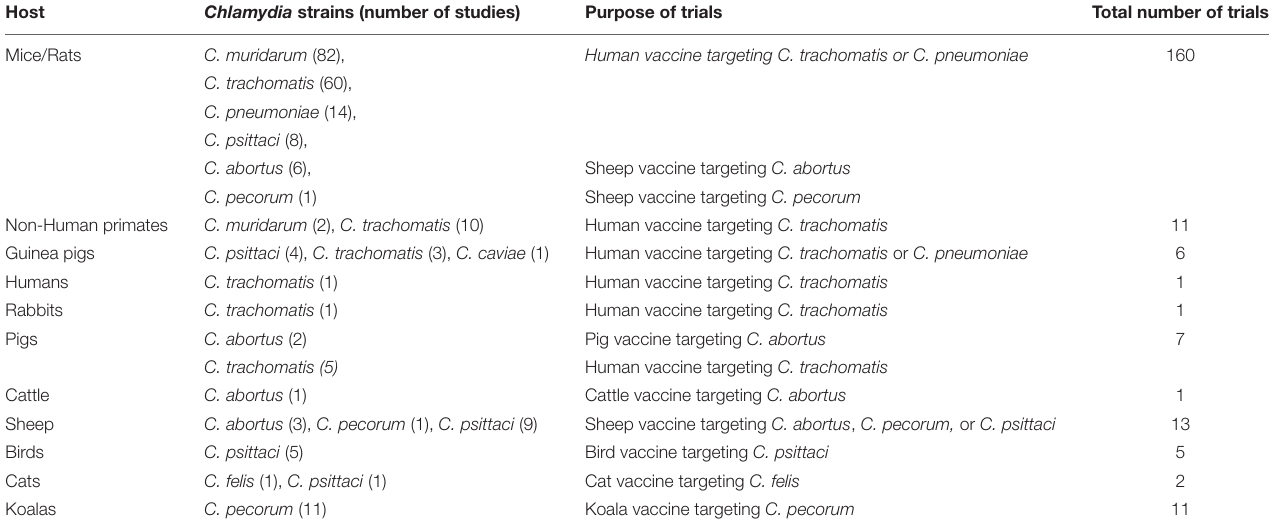
TABLE 2 | Targeted host and the number of trials for each, separated by chlamydial strain.